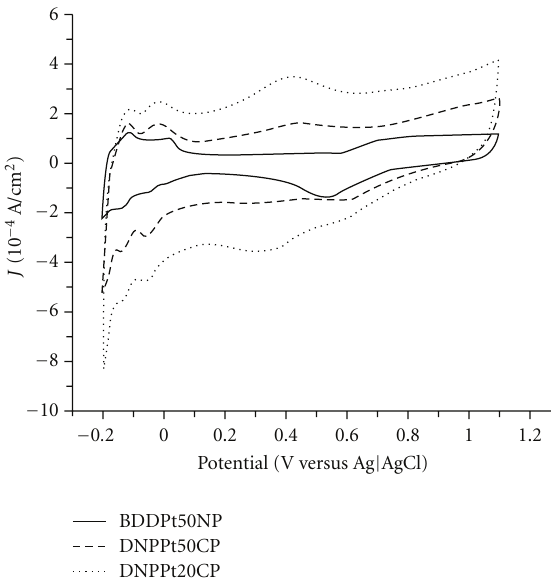
Figure 16: Cyclic voltammetry of BDD nanoparticles with 50 wt% Pt (BDDPt50NP), undoped diamond nanoparticles with 50 wt% Pt (DNPPt50CP), and with 20 wt% Pt (DNPPt20CP) in 0.5 M H 2 SO 4 (reprinted with permission from